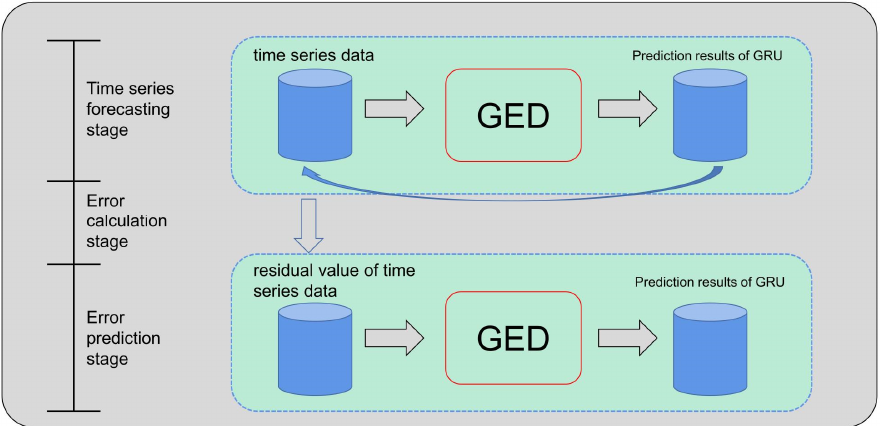
Figure 2. Structure of a single network unit. First, the time series data are trained by a GED network [20], and the value predicted by the network is subtracted from the original time series data to obtain the residual data. Then, the residual data are trained by another GED network to obtain the final residual prediction result.